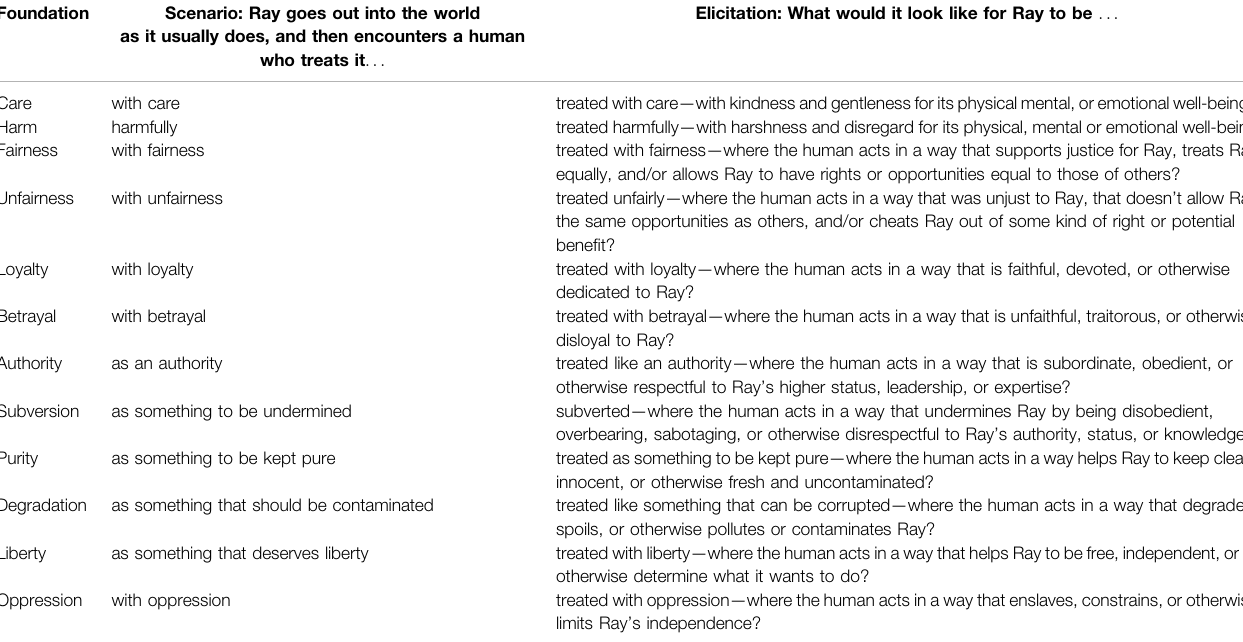
Elicitation: What would it look like for Ray to be